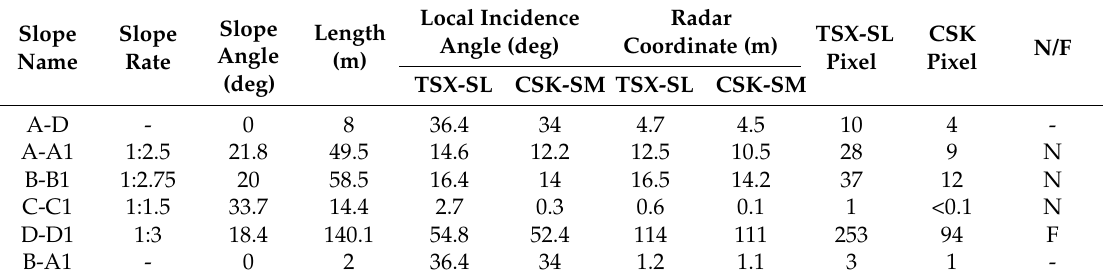
Figure 6. The transect at (0 + 235 m) of the Gongming dam (No. 4) and its surface projection on the radar coordinate. Table 2. The parameters and variables of the slope of the Gongming dam 4 on the (0 + 235 m)